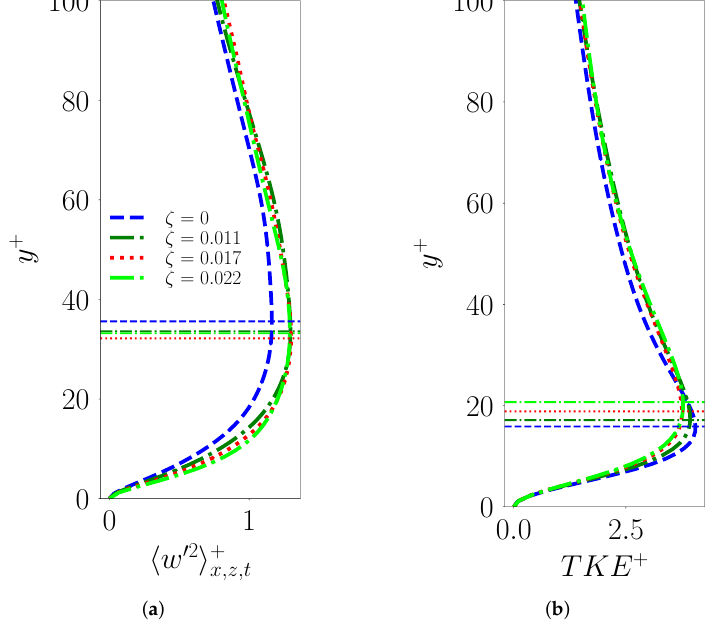
Figure 16. Inner scaled mean ( a ) spanwise variance and ( b ) turbulent kinetic energy (TKE). The horizontal lines correspond to height with maximum value of the statistics along the